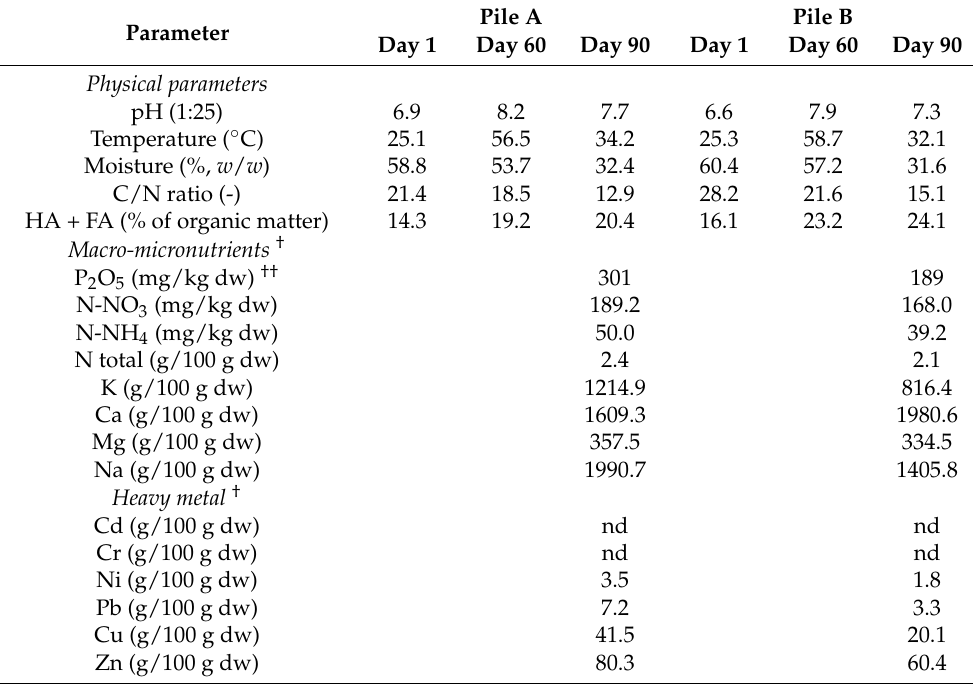
Table 6. Analytical and calculated characteristics of the composting